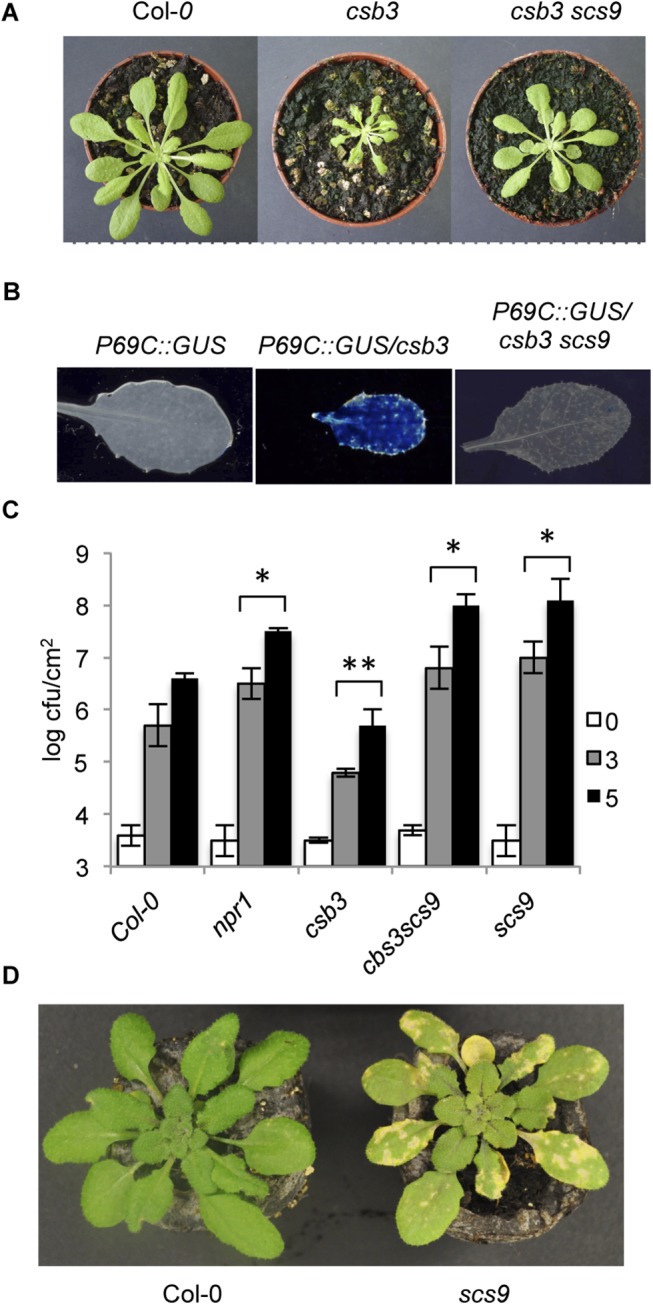
Characterization of scs9 plants.(A) Comparison of Col-0, csb3 and csb3 scs9 plants at four weeks after sowing. Note the stunted phenotype of the single csb3 mutant and the growth recovery conferred by the scs9 mutation in the double csb3 scs9 mutant. (B) Comparative histochemical analysis of GUS activity in rosette leaves from a parental wild-type Col-0 plant carrying the pP69C:GUS transgene, which shows no constitutive expression of the transgene (left), from csb3 plants showing the constitutive activation of the transgene (center), and the reversion of this molecular phenotype in the double csb3 scs9 mutant plant (right). (C) Growth rates of virulent P.s DC3000 in Col-0, npr1-1, csb3, csb3 scs9, and scs9 plants. Bacterial growth was measured at zero (white bars), three (grey bars), and five (black bars) days after inoculation. Error bars represent standard deviation (n = 12). Asterisks indicate statistical differences to Col-0 (P<0.05) using a Student’s t-test. (D) Representatives of P.s. DC3000 inoculated Col-0 and scs9 plants, where the scs9 mutant exhibits a distinguishable enhancement of chlorosis due to bacterial growth.